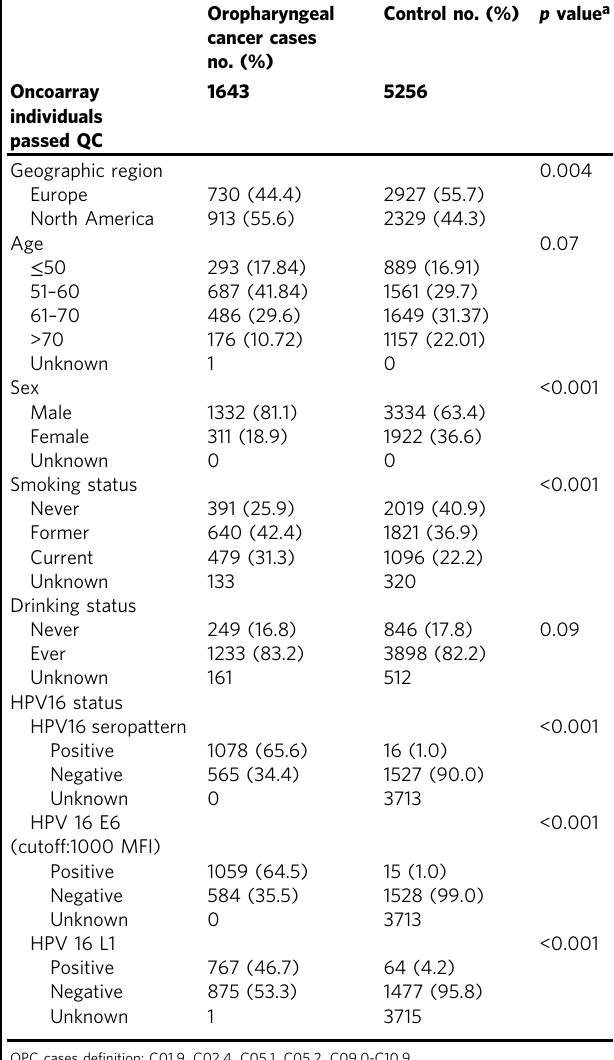
Table 1 Background characteristics of the participating subjects after quality